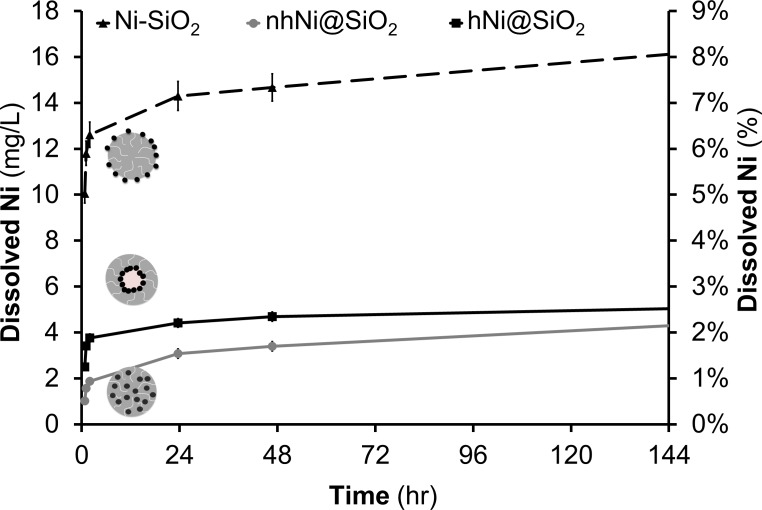
Nickel amount dissolved and percent dissolution of Ni-containing CEN in E3 medium at room temperature for 5 days with a starting concentration of 200 mg Ni/L.Ni-SiO2 had the highest Ni2+ dissolution.